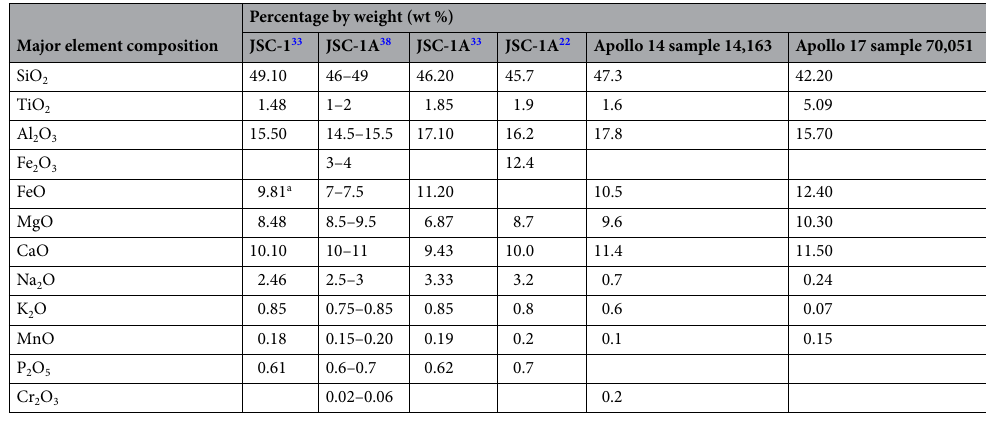
Table 1. Chemical composition, expressed as weight%, of lunar soil and simulants. a Total Fe is expressed as FeO, where stated. Fe 2 O 3 content of JSC-1A was estimated based on the material safety reference 22